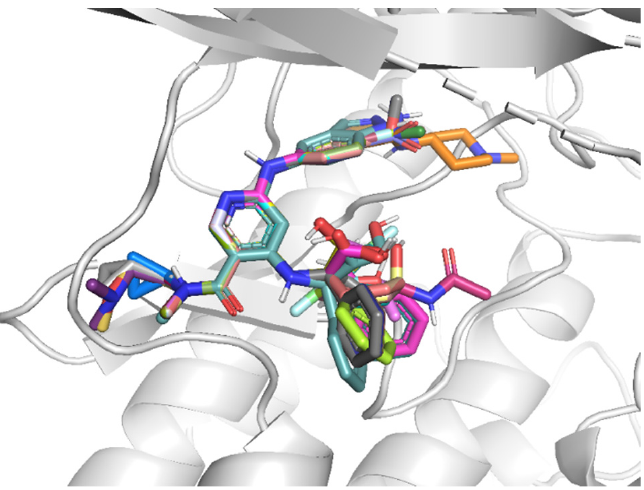
Figure 5. Alignment of the dataset compounds inside the active site of IRAK4.